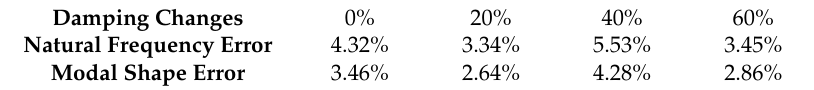
Table 5. Identification error of simulated absorber faults.